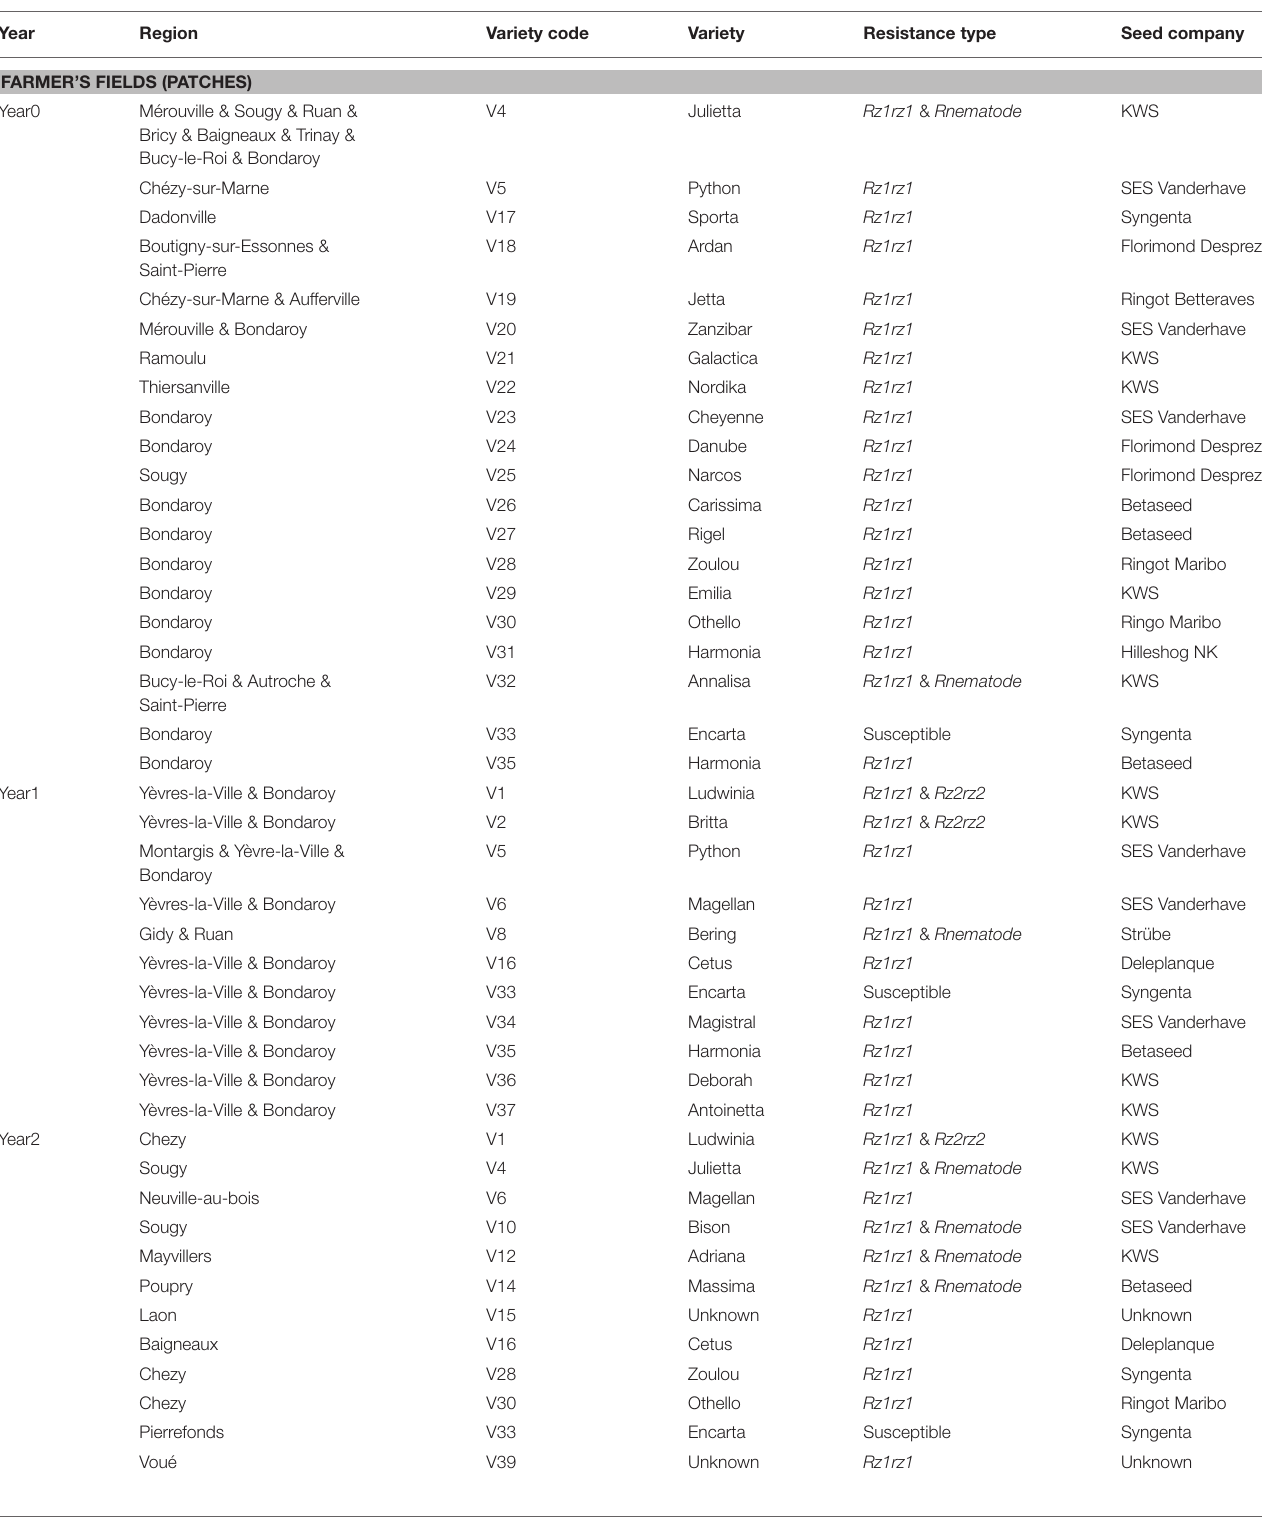
TABLE 2 | Plant material from farmer’s fields. Region Variety code Variety Resistance